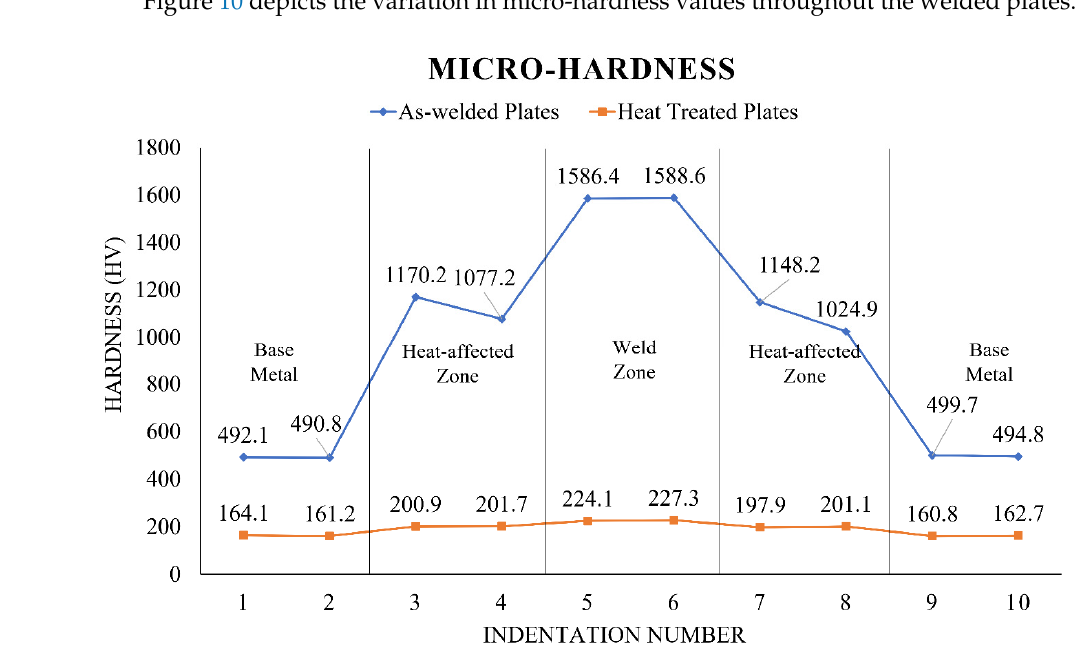
Figure 10. Values of micro-hardness test.